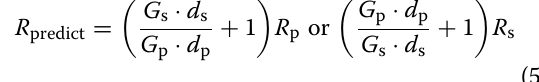
Table 1 Specifications of lamina